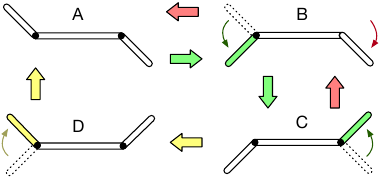
Figure 1. Graphical description of reciprocal (green-red arrow path, A-B-C-B-A) and non-reciprocal (green-yellow arrow path, A-B-C-D-A) motion with a Purcell’s swimming